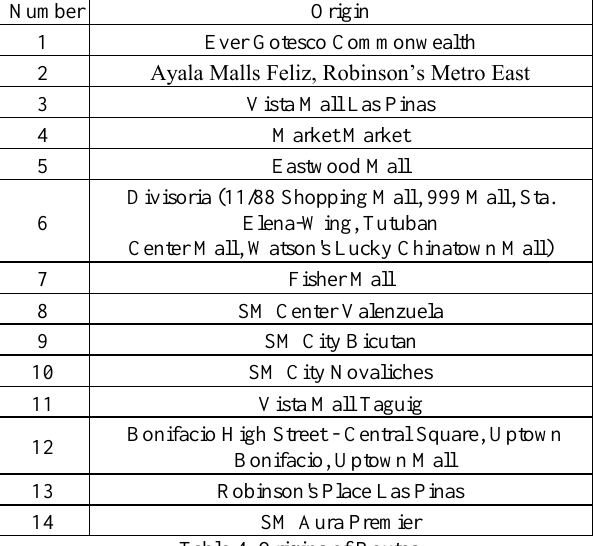
Table 4. Origins of